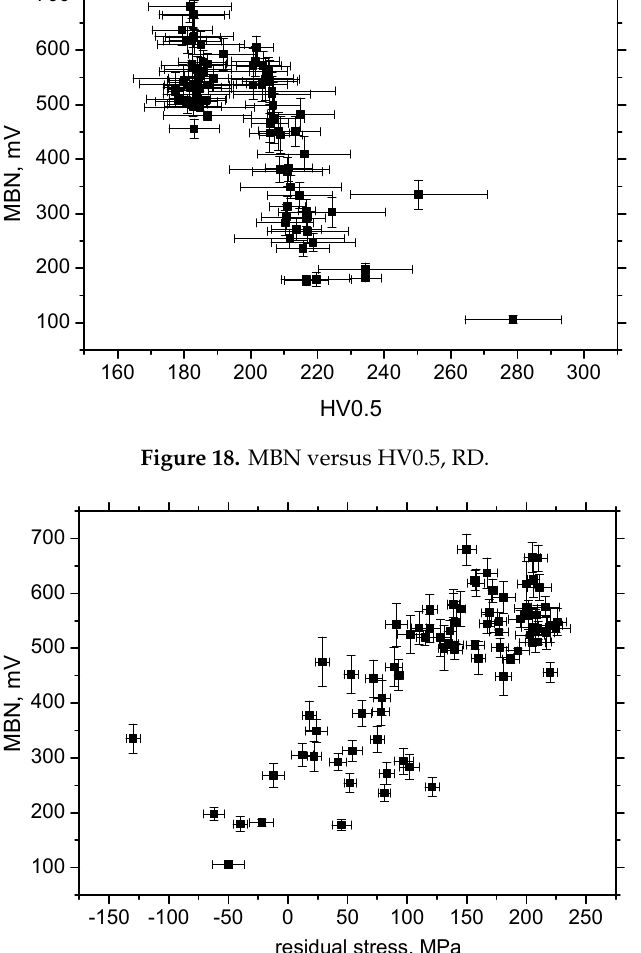
Figure 19. MBN versus residual stresses, RD.